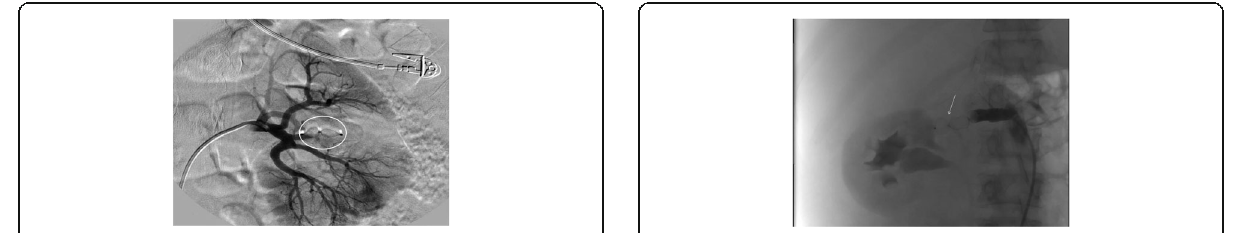
Fig. 5 Neoplastic mass treatment. Subsequent treatment with the